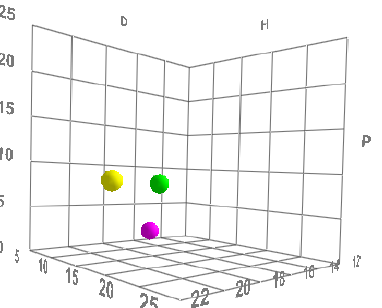
Figure 1. Illustrative representation of three different elements (formulation, active and skin) that are placed, according to their HSPs, in Hansen’s space. Image of a graph created by Formulating for Efficacy ® Software, using the three-dimensional Hansen representation. D = energy from dispersion forces; P = energy from dipolar intermolecular force; H = energy from hydrogen bonds. Reprinted and adapted with permissions from [9,10].